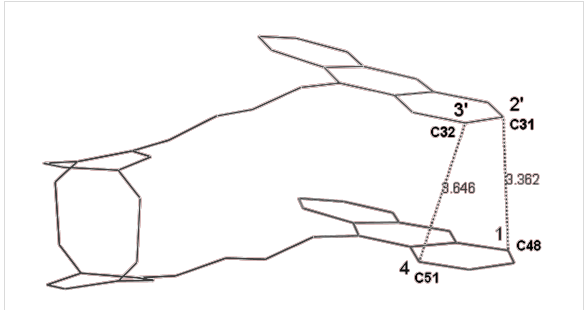
Figure 5: Projection of the molecular structure of 2 exhibiting the closest internuclear distances (distances in Å).